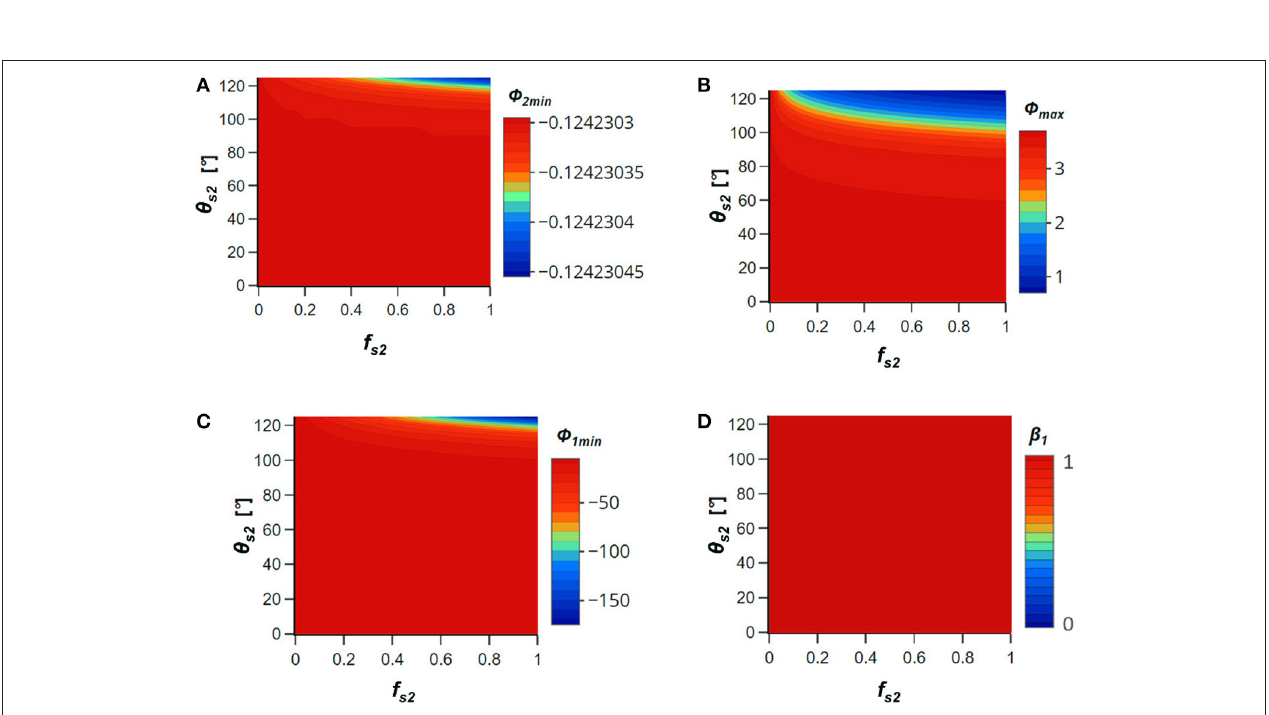
FIGURE 5 | Contour plots of (A) Φ 2min , (B) Φ max , (C) Φ 1min , and (D) β 1 for a hydrophilic bacterium when the IS h cr 25nm) and solid phase ( f sr 0.1 and h sr 50nm) have roughness. The solid phase Hamaker constant and fraction on site 2 were varied from A s 2 = = = 10 − 20 to 10 10 − 20 J and f s 2 0 to 1 ( Figure 1 ). Table 1 gives a summary of all parameters. × =